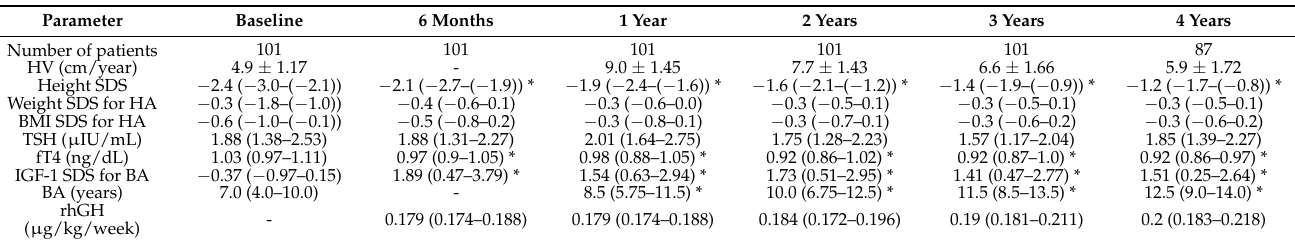
Table 1. Characteristics of anthropometric parameters, biochemical parameters, bone age value and rhGH doses. Parameter Baseline